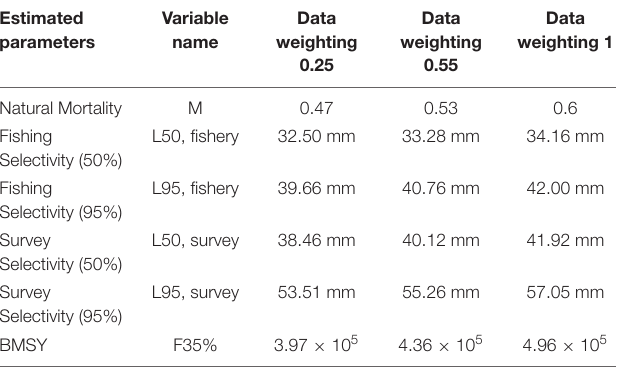
TABLE 4 | Difference in parameter of the model estimating under three data weightings. Estimated